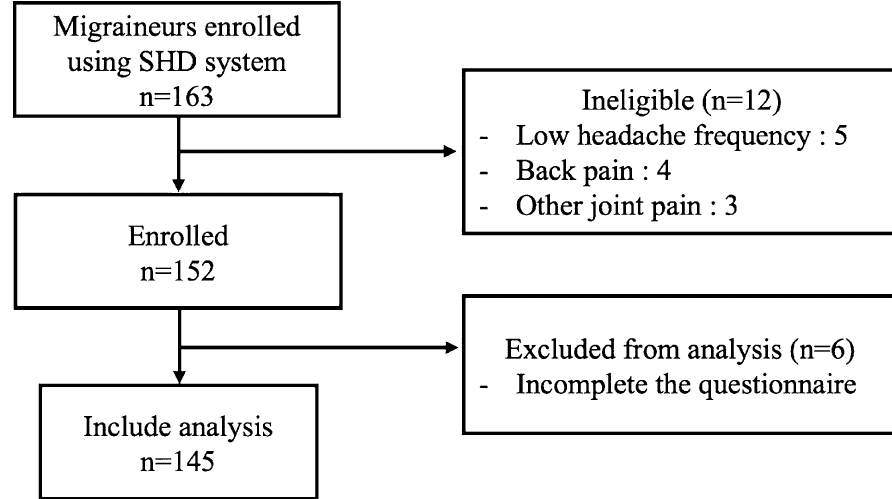
Figure 2. Flow chart depicting the migraine participation by using smartphone headache diary